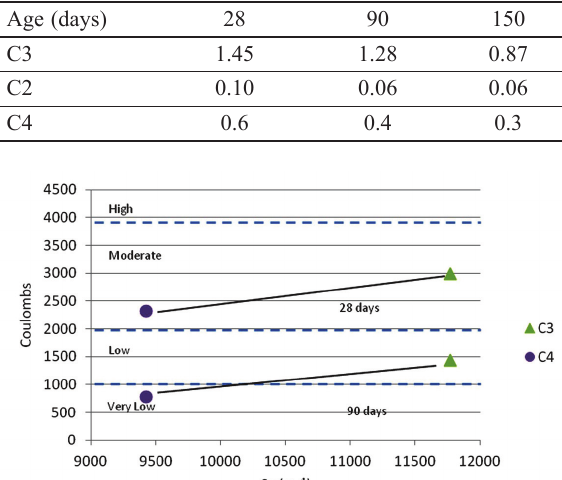
Table 10. Standard deviation of air permeability